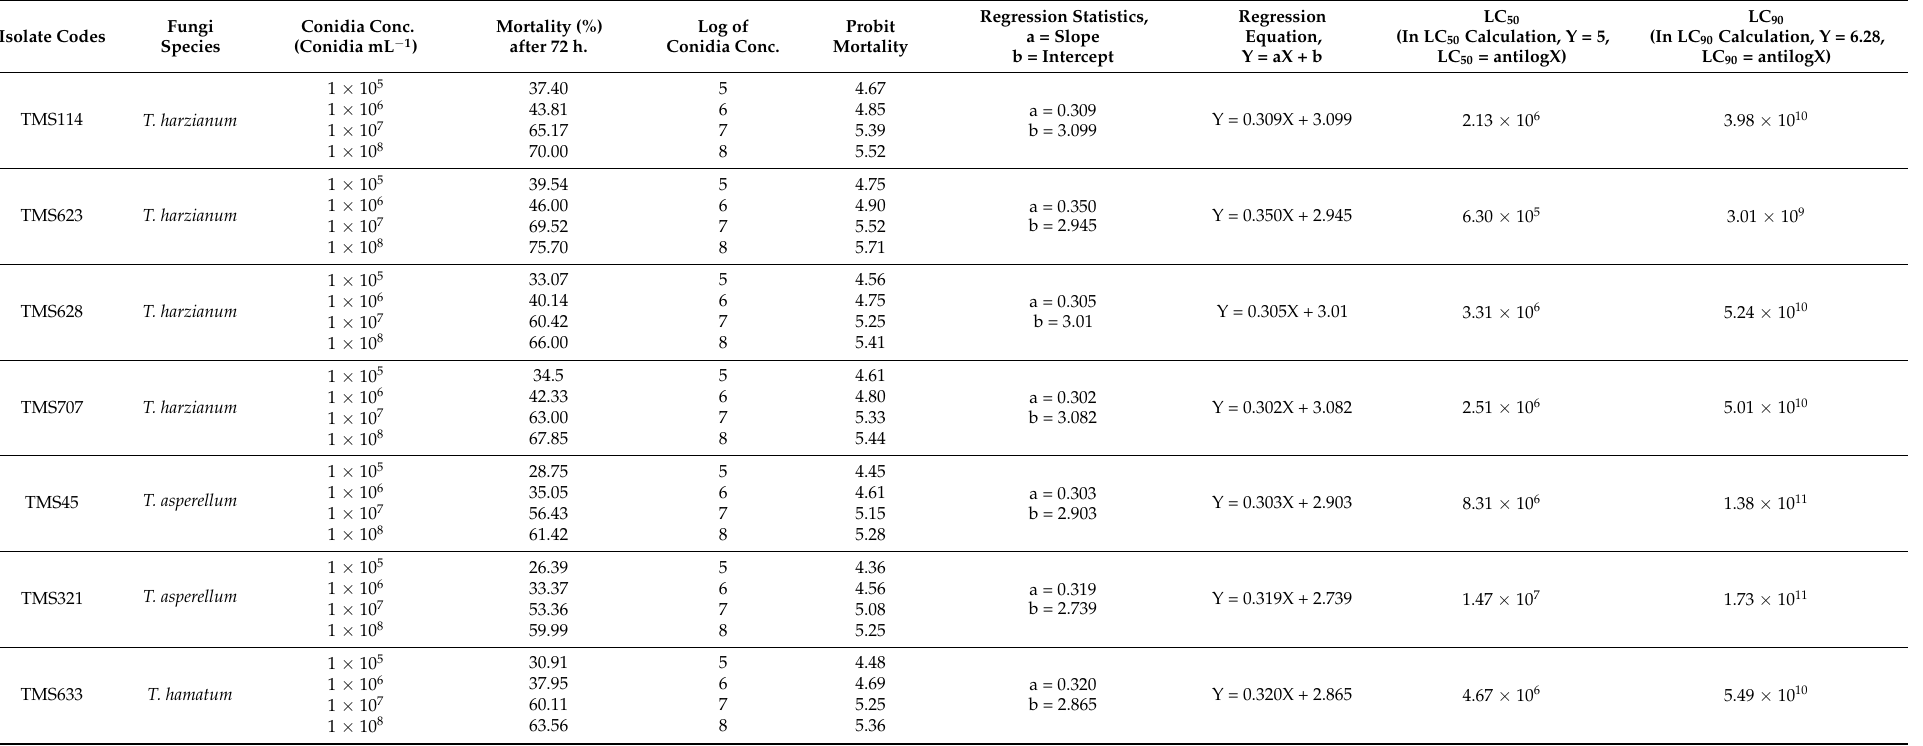
Table 2. LC 50 & LC 90 values for the efficacy of isolates against nymphs using different concentrations (1 × 10 5 to 1 × 10 8 conidia mL − 1 ) of conidia suspension after 72 h